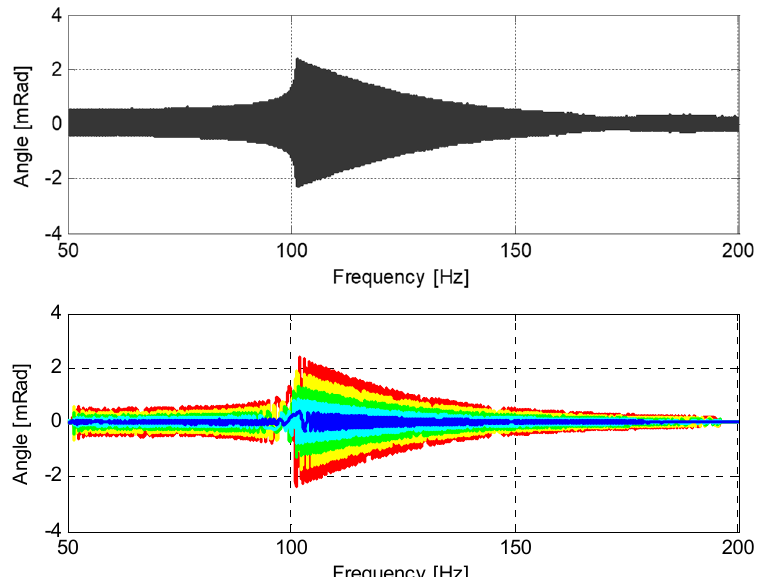
Figure 15. The results of RC testing. Standard RC test results are at the top; the results from the